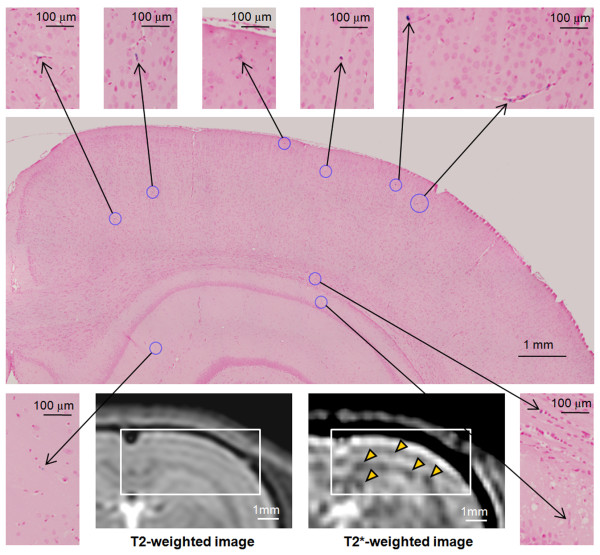
MRI with histological correlation of group 1 rat. Prussian blue staining of the coronal section of brain and MRI shows the distribution of ferumoxides labeled cells in the brain at day 1 post IC infusion of 3 × 106 cells. The T2*w image shows many hypointense spot due to metastatic tumor cells in the cerebral cortex and hippocampus. Inset in the MRI indicates the area photographed in Prussian blue staining (center). Although the differences in the slice thickness of the histological section (6 μm) and MRI (500 μm) precluded direct spatial co-localization of iron positive lesions, the distribution pattern of metastasis can be appreciated.